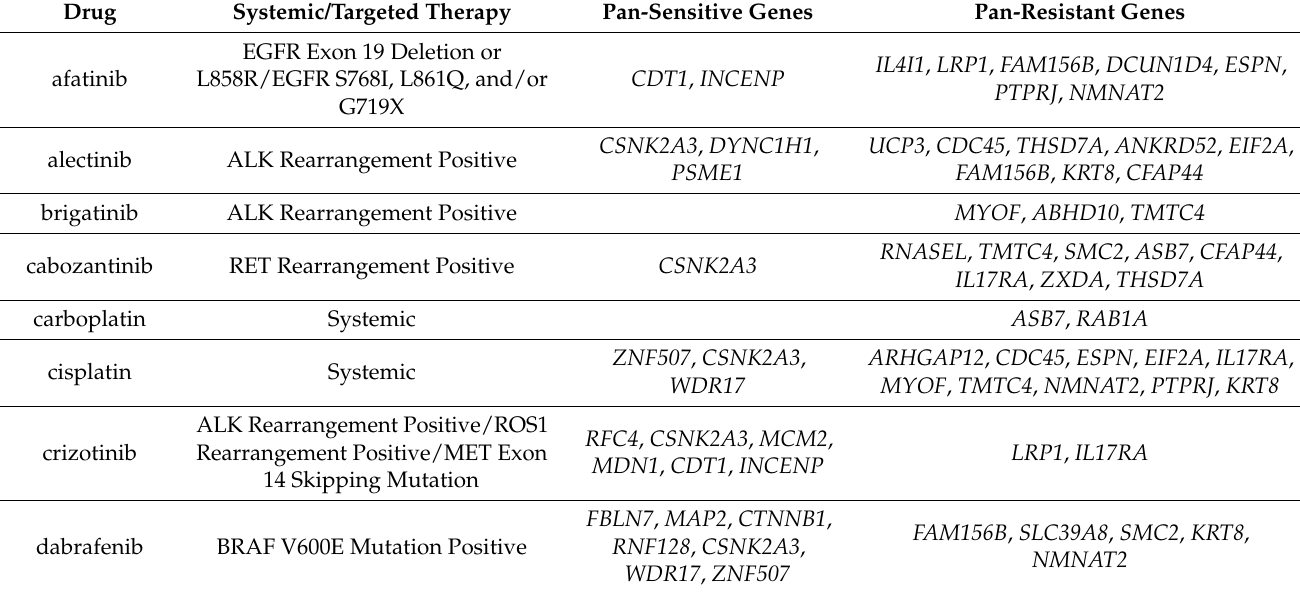
Table 1. Pan-sensitive and pan-resistant genes to 21 drugs using RNA sequencing data in CCLE NSCLC cell lines ( n =